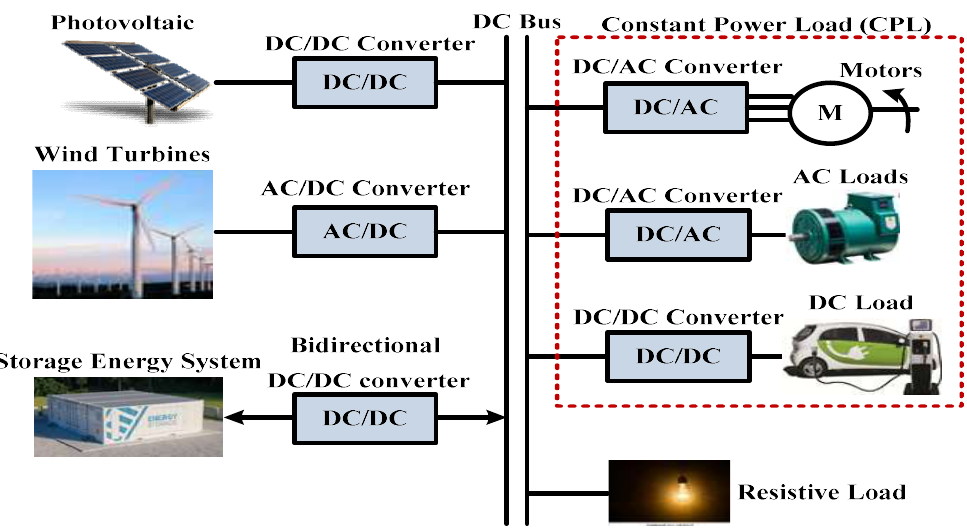
Figure 1. The structure of a DC microgrid with various loads and sources.